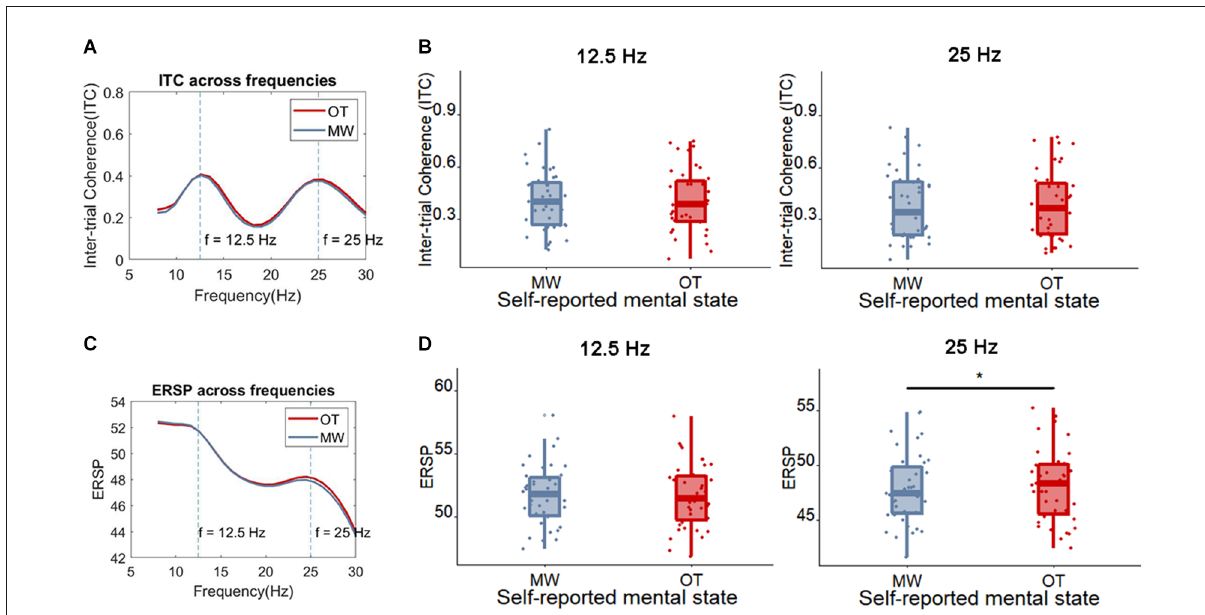
FIGURE9 (A) The average ITC across frequencies comparing the trials in which participants reported being on-task (OT) vs. mind-wandering (MW). (B) Boxplot of the ITC at the frequency of 12.5 Hz and 25 Hz for OT and MW trials, each dot represents one participant. (C) The average ERSP ((log)dB) across frequencies for on-task (OT) and mind-wandering (MW) trials. (D) Boxplot of the ERSP at the frequency of 12.5 Hz and 25 Hz for OT and MW trials, each dot represents one participant. The only observable difference (indicated with *) is found between on-task and mind-wandering in the ERSP at 25 Hz, which is significantly higher for on-task.